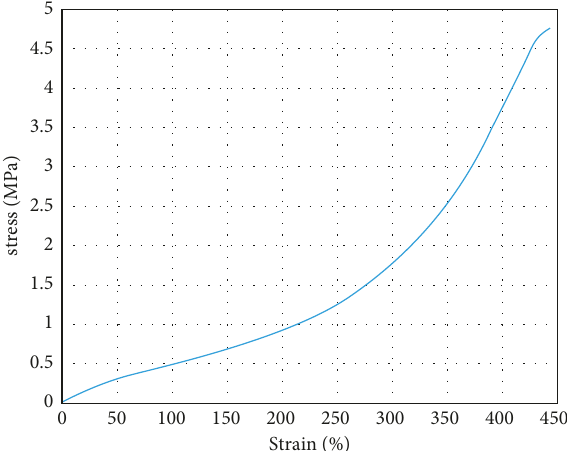
Figure 4: Graph of rubber shear stress-strain curve.